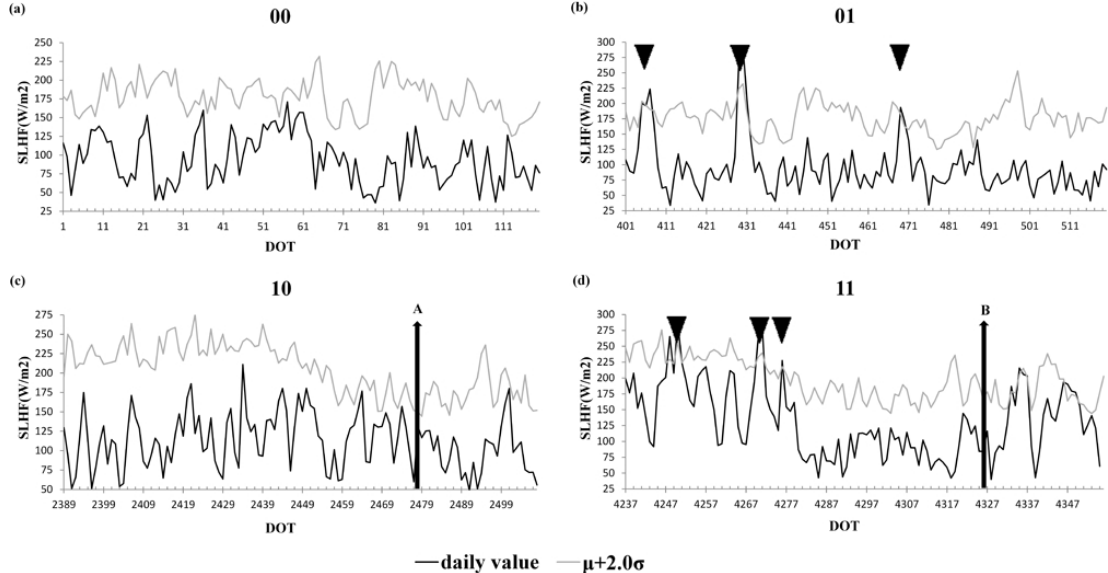
Fig. 2. The four types of relationships between SLHF anomalies and earthquakes.